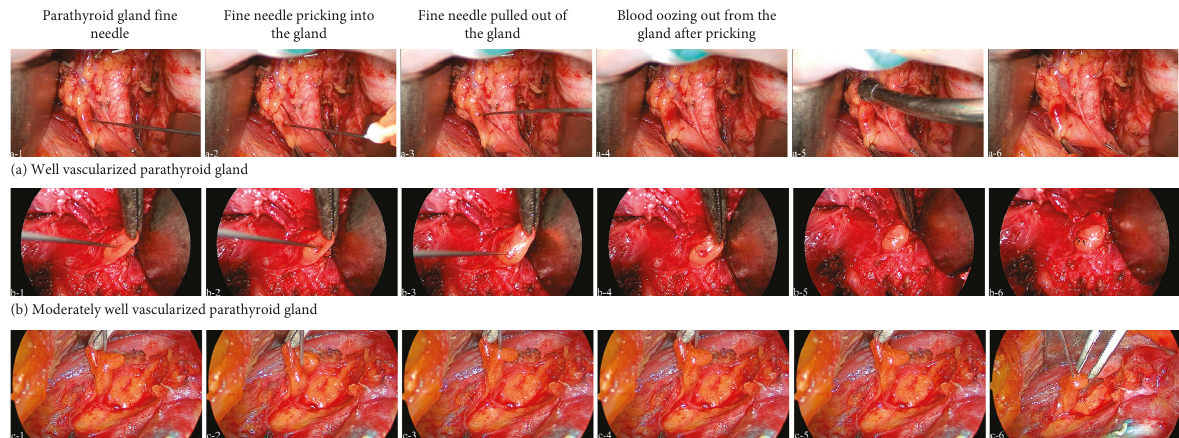
Figure 1: Representative parathyroid gland fine-needle pricking (FNP) test images. (a) A well-vascularized parathyroid gland (FNP score of 2). a-5, the blood covering the gland was cleared by suction. At a-6, blood was still oozing out from the incision of the gland. (b) A moderately well-vascularized parathyroid gland (FNP of score 1). b-5, the blood covering the gland was wiped by gauze. b-6, small and slow blood oozing from the incision of the gland was detected (black arrow). (c) A devascularized parathyroid gland (FNP score of 0). c-5, no blood oozing out from the incision of the gland waited for 10 to 20 seconds after the pricking. c-6, no blood oozing out after more times pricking of the gland.